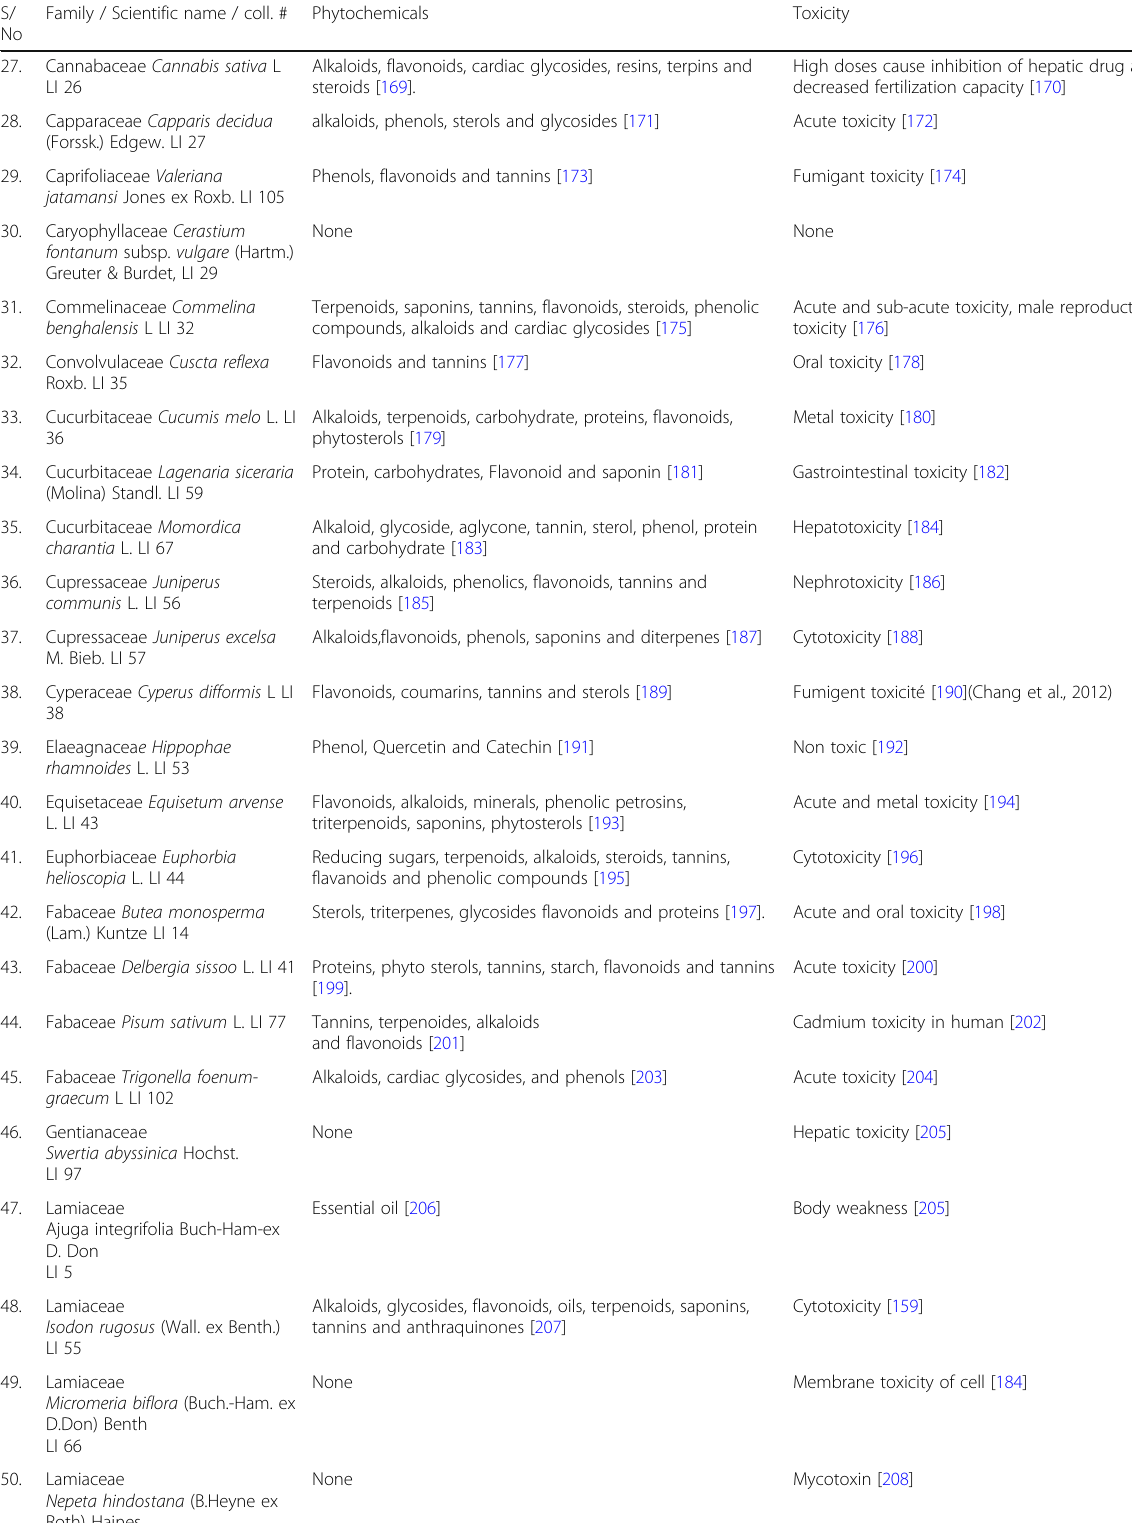
Table 5 Phytochemical activities and toxicity of medicinal plants used for skin diseases (Continued) S/ Family / Scientific name / coll. # No